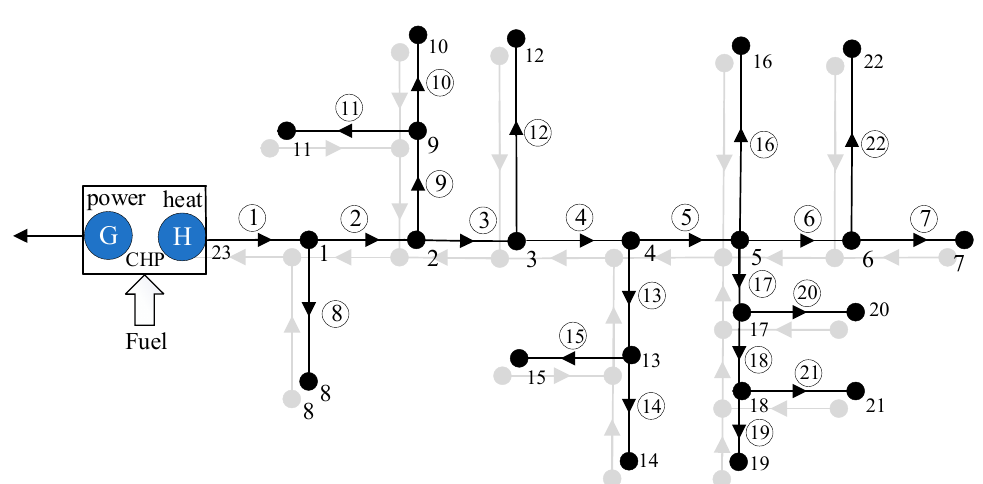
Figure 3. System diagram of the 23-node heat distribution network employed as a case study.